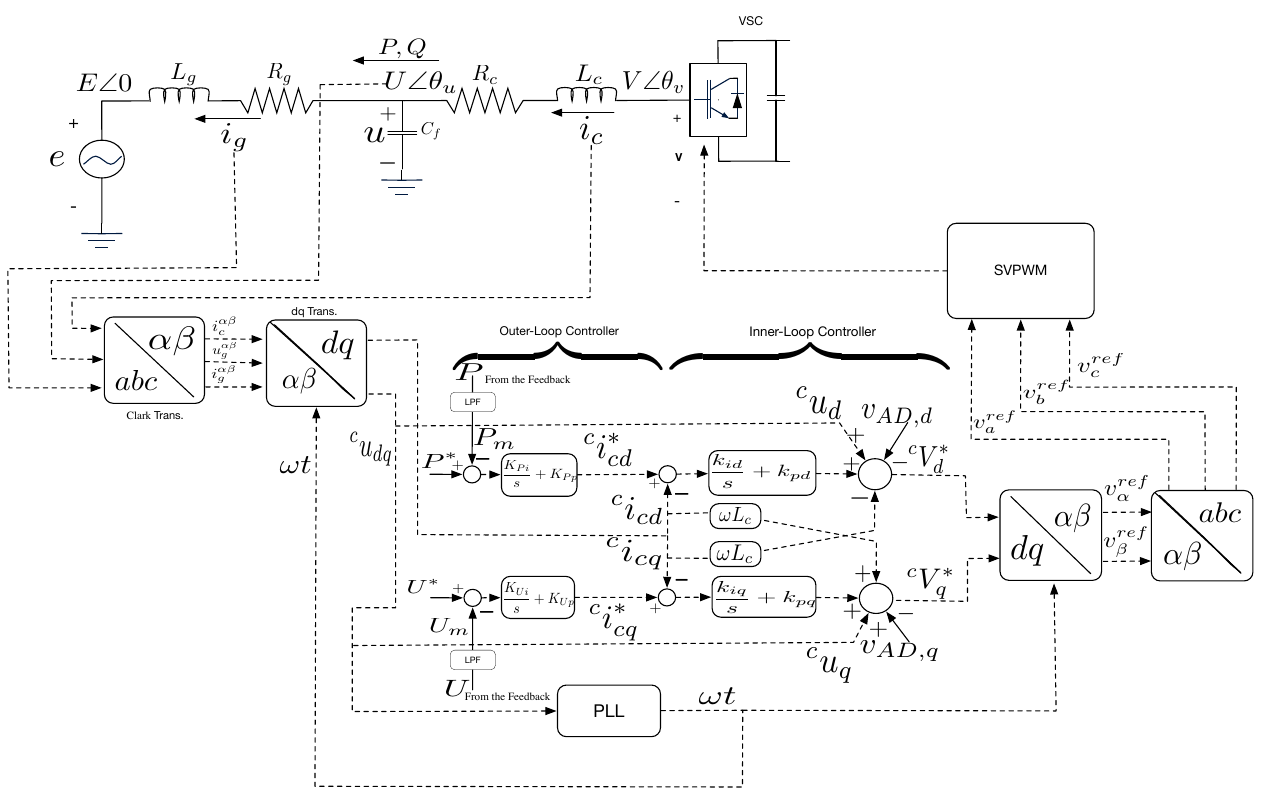
Figure 1. Closed Loop for VSC-HVDC